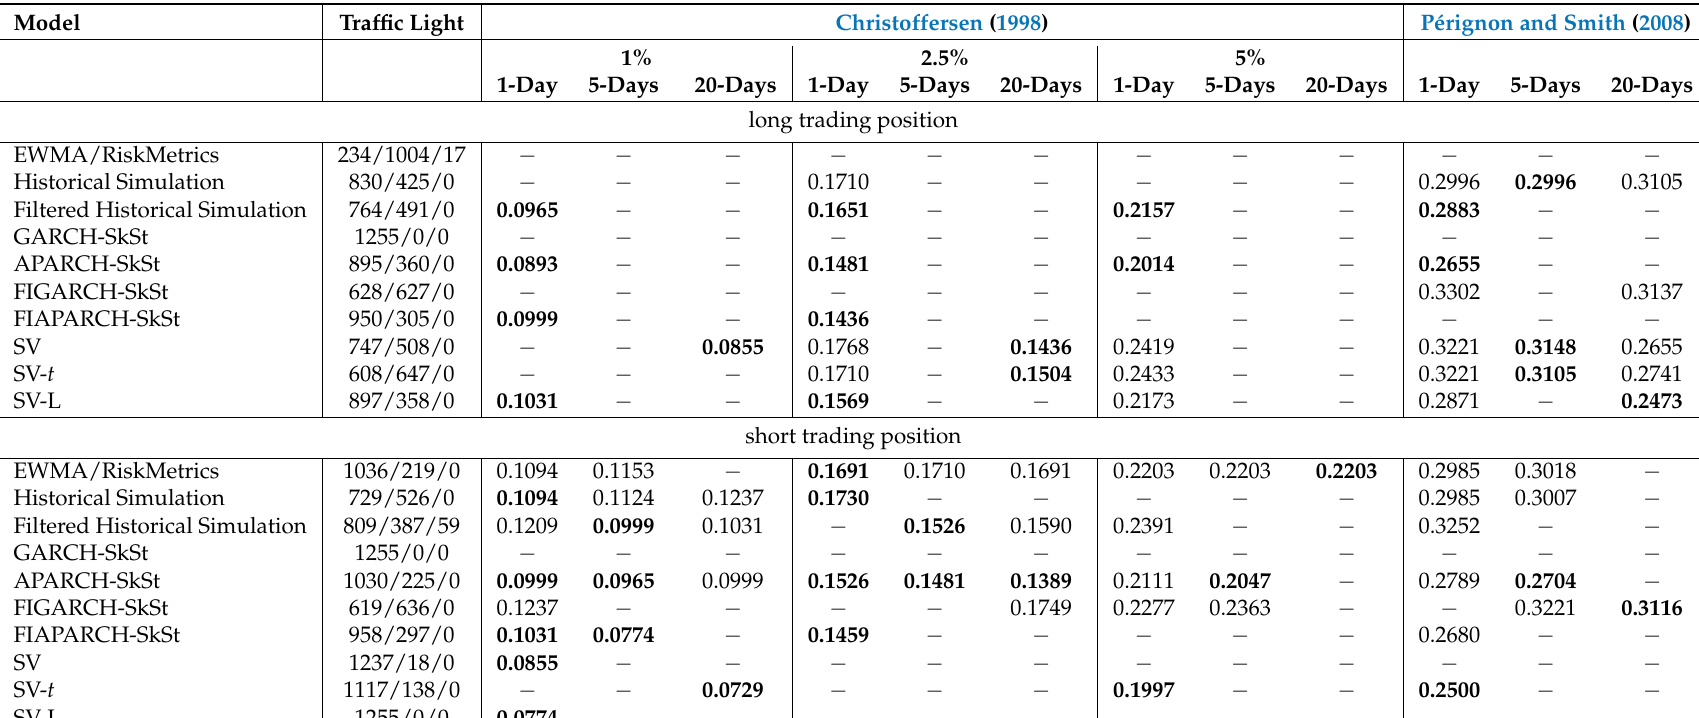
Table 6. Value-at-Risk backtest results for STI